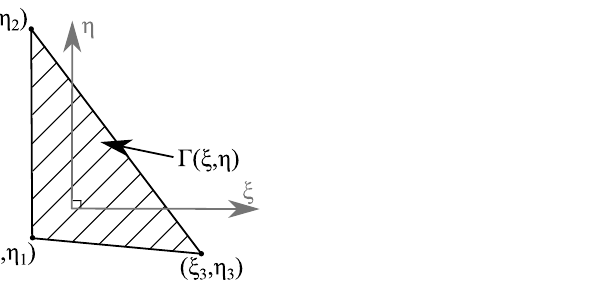
Figure 6. A top-down view of a DDE in the local coordinate